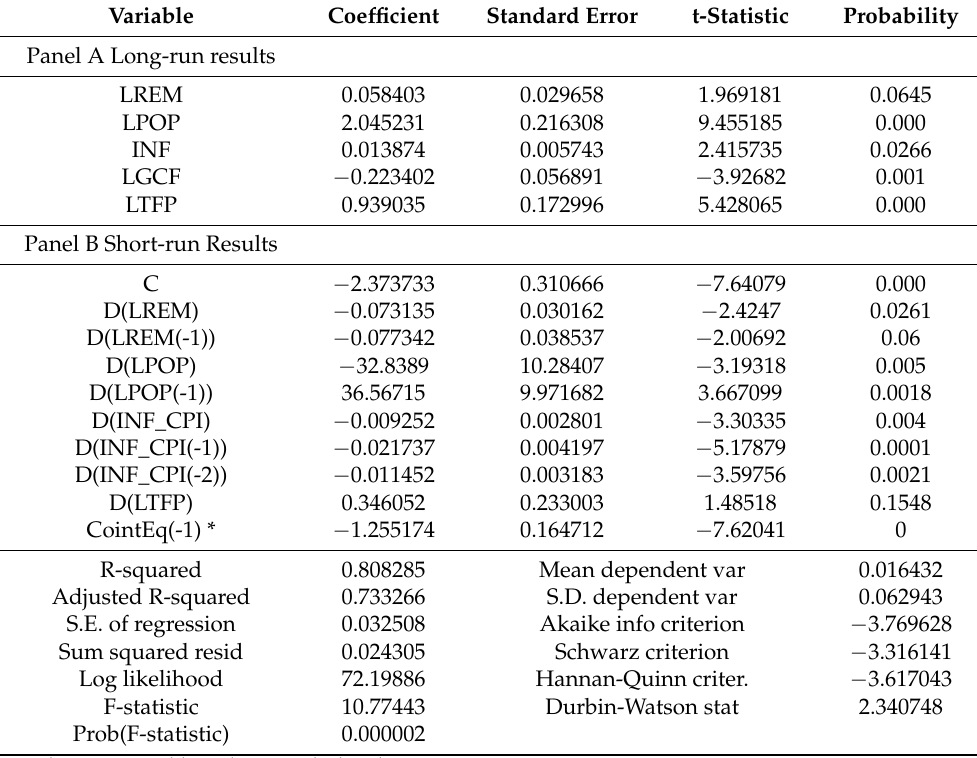
Table 4. ARDL long-run and short-run